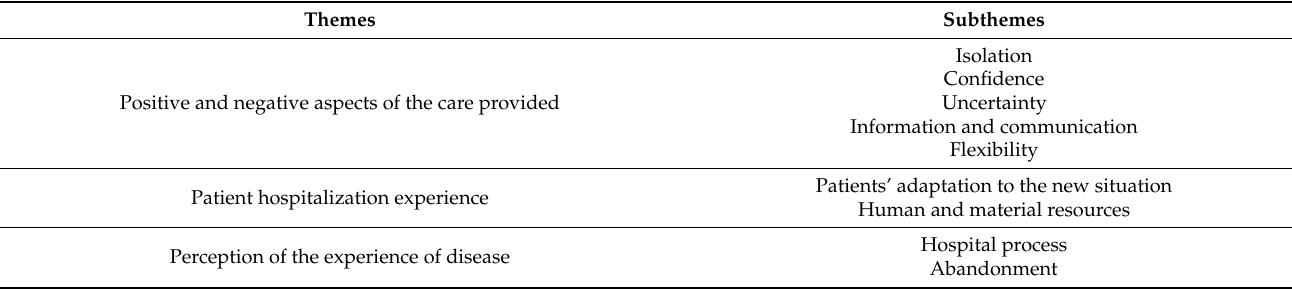
Table A3. Overview of themes and